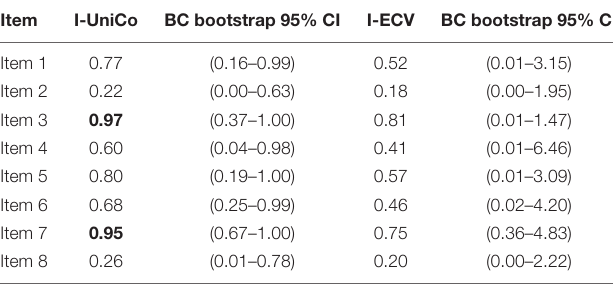
TABLE 3 | Exploratory bifactor model: item-level closeness to unidimensionality.